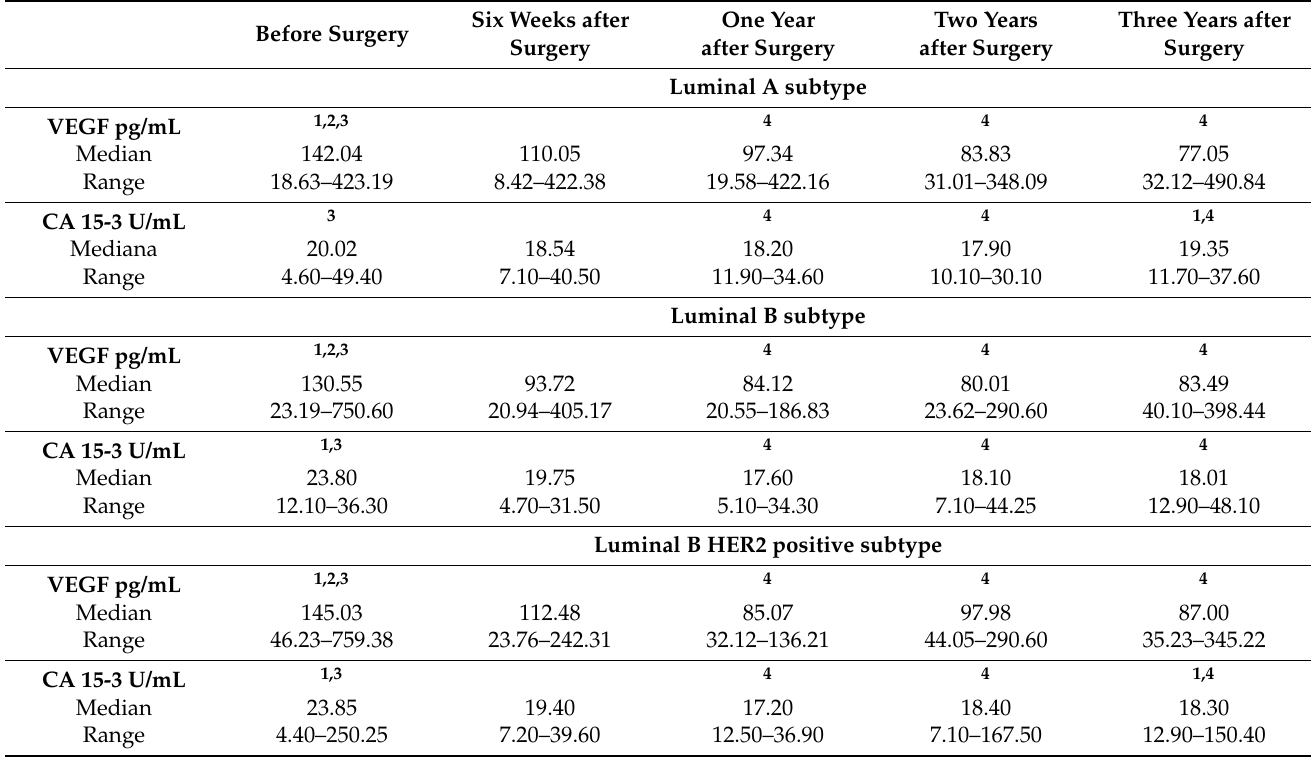
Table 3. Plasma levels of tested parameters in a three-year follow-up, groups by the molecular subtype of BC. Six Weeks after One Year Before Surgery Surgery after